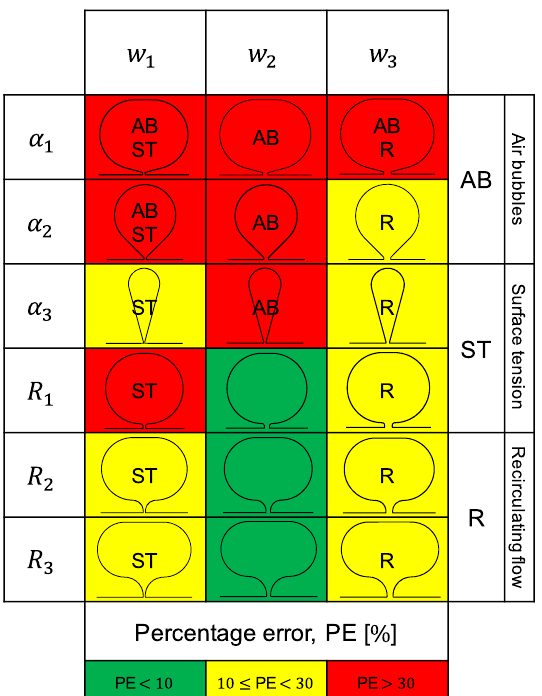
Figure 7. Summary of the results. The colour scheme reflects the average error in the experimental pressure drop, ∆ P , when compared to the analytical solution, per pressure tap